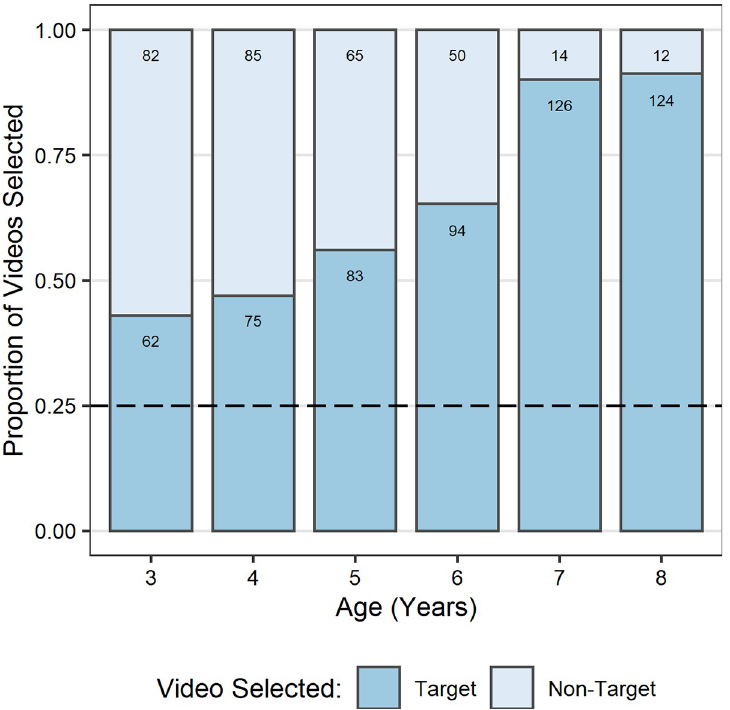
Fig 2. Proportion of target and non-target demonstration video selections ( N = 872) by age in years. Target video selections equate to appropriate information seeking. All age groups selected the target video significantly above chance. Values presented on bars refer to the number of trials each proportion represents. Dashed line indicates